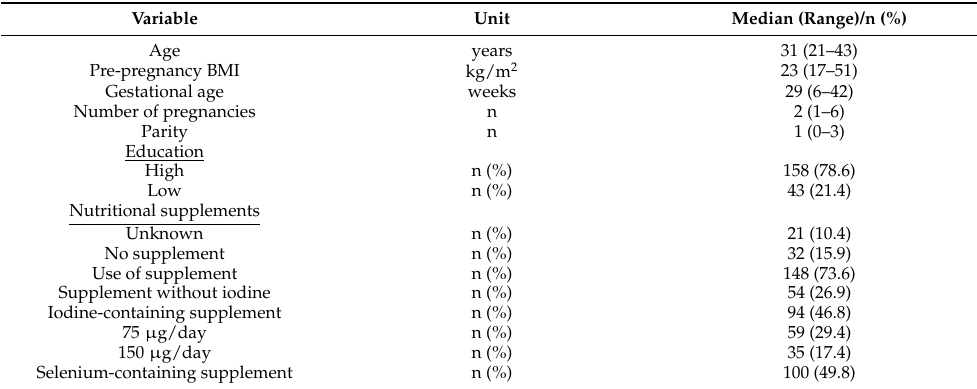
Table 1. Characteristics of the pregnant women included in the JOZO